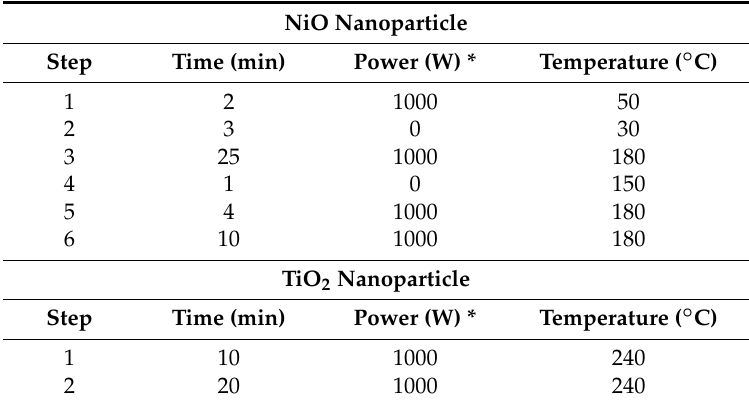
Table 4. Digestion program of NiO and TiO 2 nanoparticle in lung and BALF. NiO